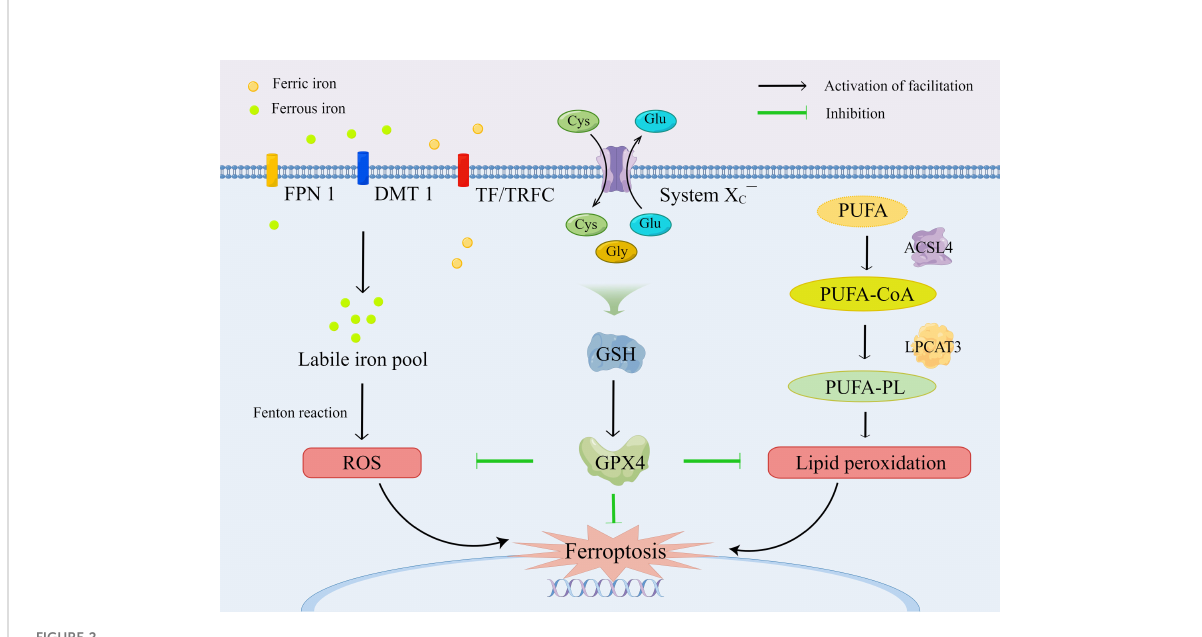
FIGURE 2 The molecular mechanism and regulation of